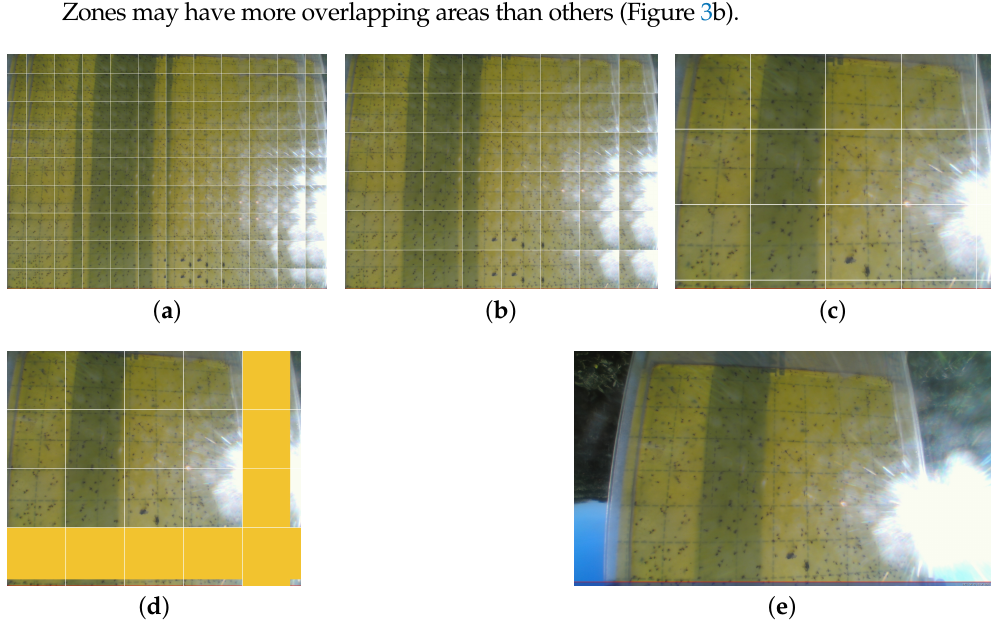
Figure 3. Yellow sticky card splitting approaches. ( a ) ODS approach. ( b ) OSS approach. ( c ) PS approach. ( d ) PSB approach. ( e ) Original